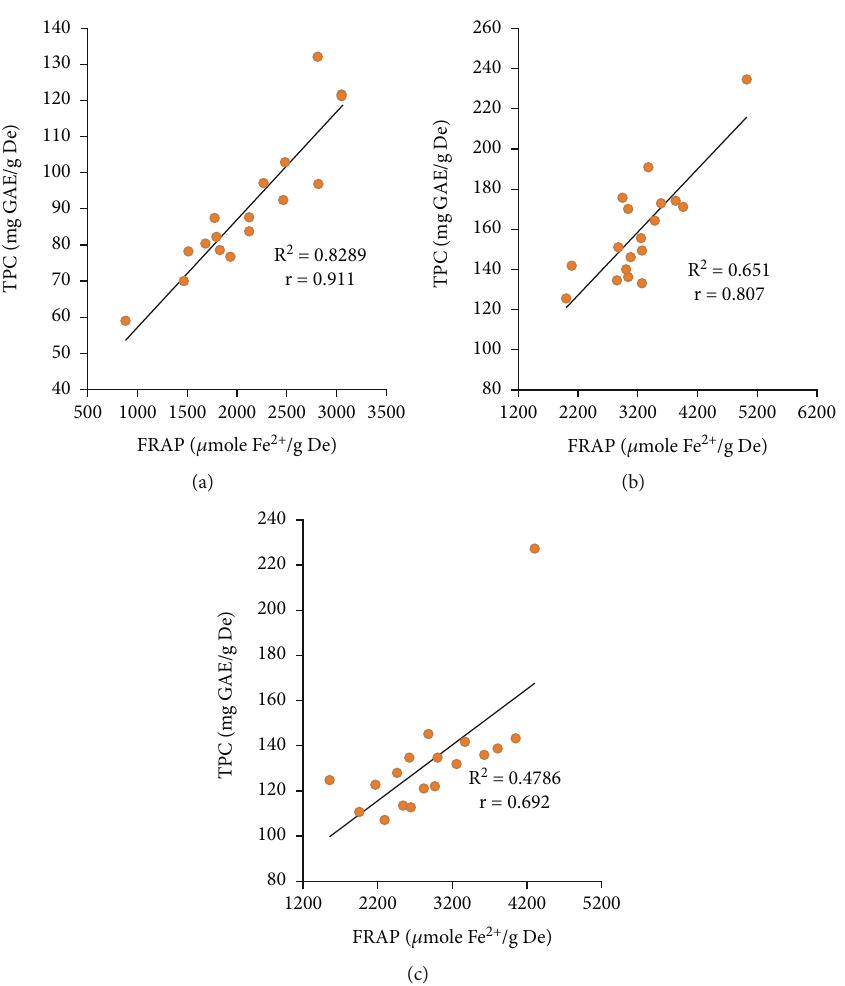
Figure 3: Correlation between TPC and antioxidant capacity (FRAP) of extracts of (a) seed, (b) epicarp, and (c) seed Table 2: Parameters of the model by parts obtained from the PLE extraction kinetics of epicarp ( E ), seed ( S ), and seed tegument (ST) of avocado var. Hass at 318 K, 225bar and Et as solvent.